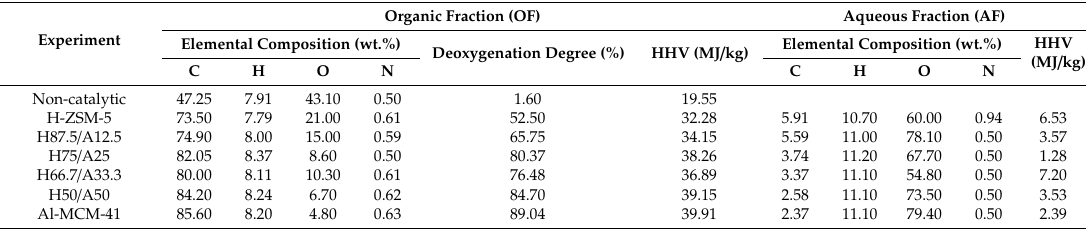
Table 2. Elemental composition of Organic Fraction (OF) and Aqueous Fraction (AF) in liquid (wt.%), the deoxygenation degree (%), and the High Heating Value (HHV) in OF for non-catalytic and catalytic pyrolysis with di ff erent proportions of H-ZSM-5 and Al-MCM-41.